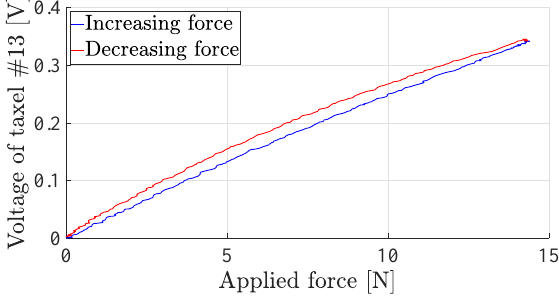
Figure 6. Force–voltage hysteresis curve of a sensor